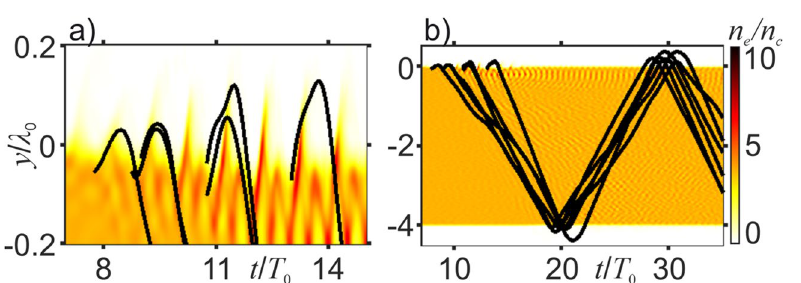
Figure 2. Oscillatory electron y ( t ) traces that start at different ( y , t ) space–time points, (–0.05 λ 0 , 7.8 T 0 ), (–0.06